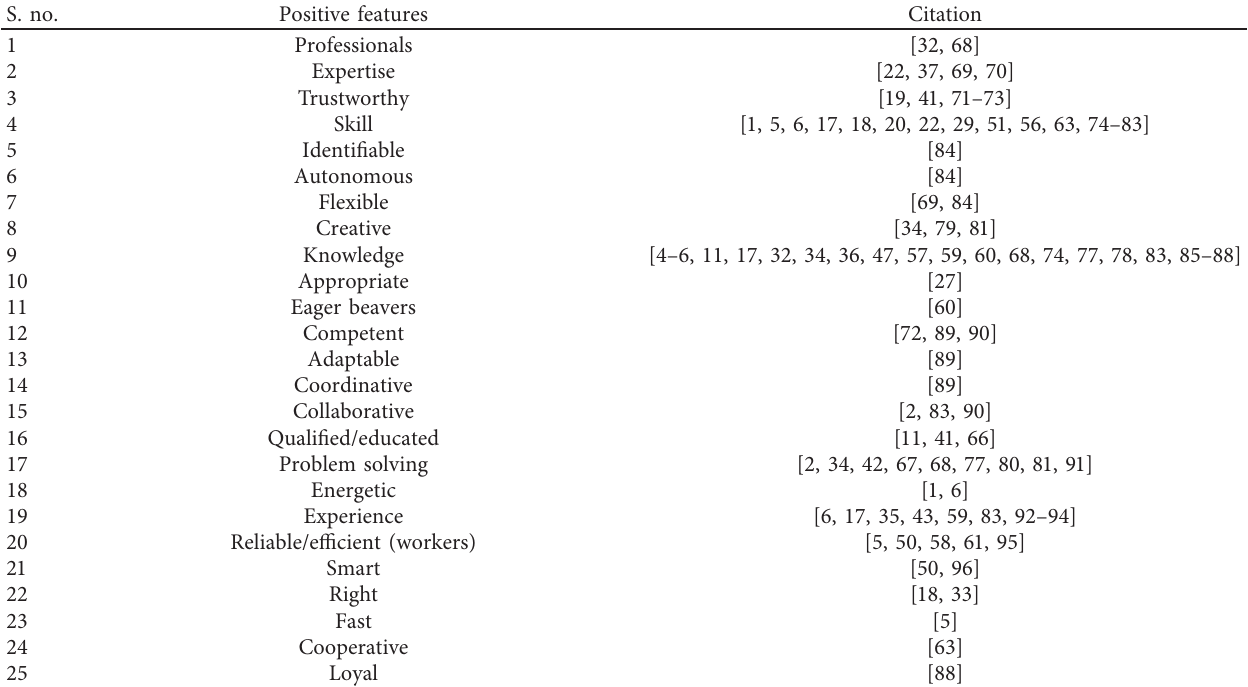
Table 3: Representation of positive crowd